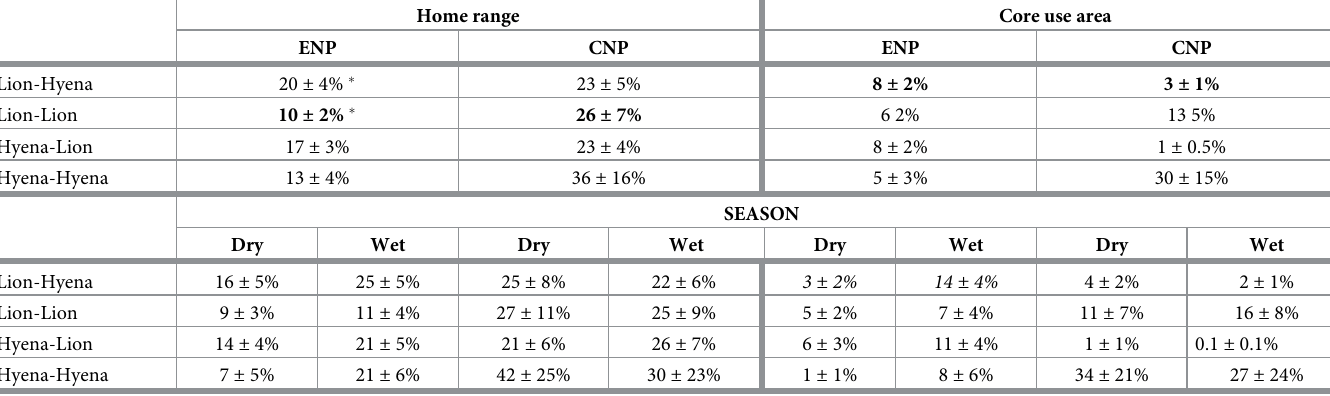
Table 4. Percentage range overlaps in the home ranges and core use areas between lions and spotted hyenas, lion conspecifics, hyenas and lions, or hyena conspecifics.